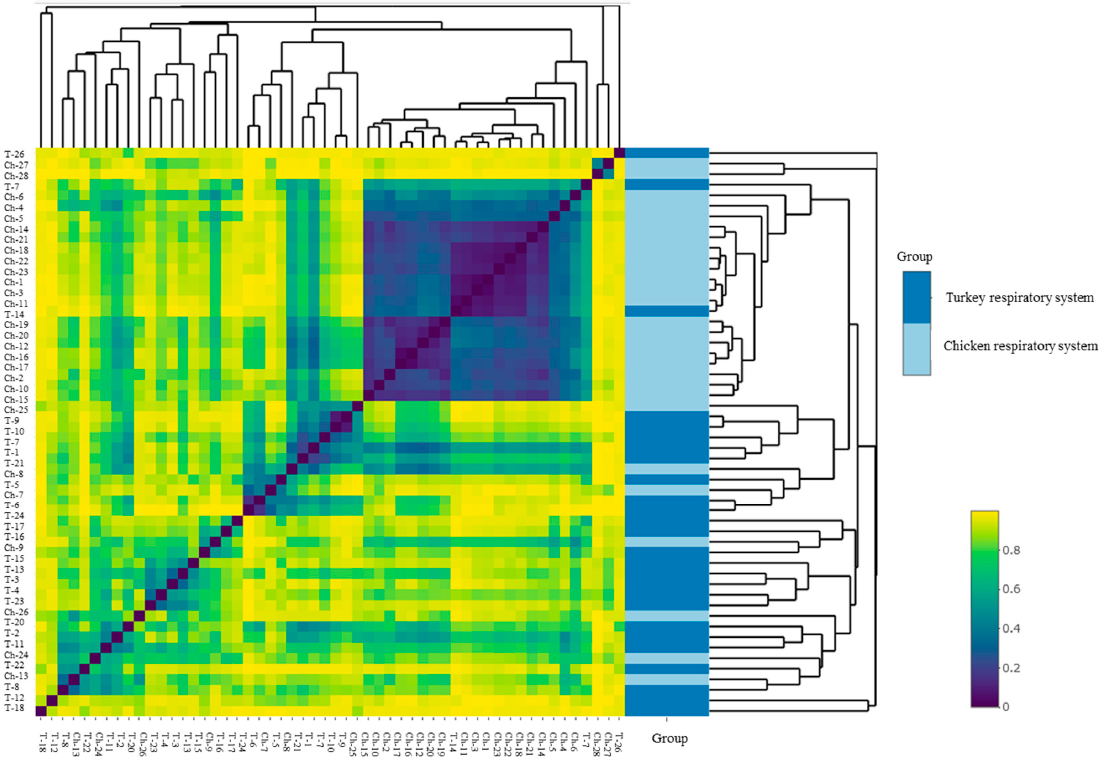
Figure 6. Beta diversity heatmap of chicken and turkey URT bacterial communities generated with the Bray–Curtis method.